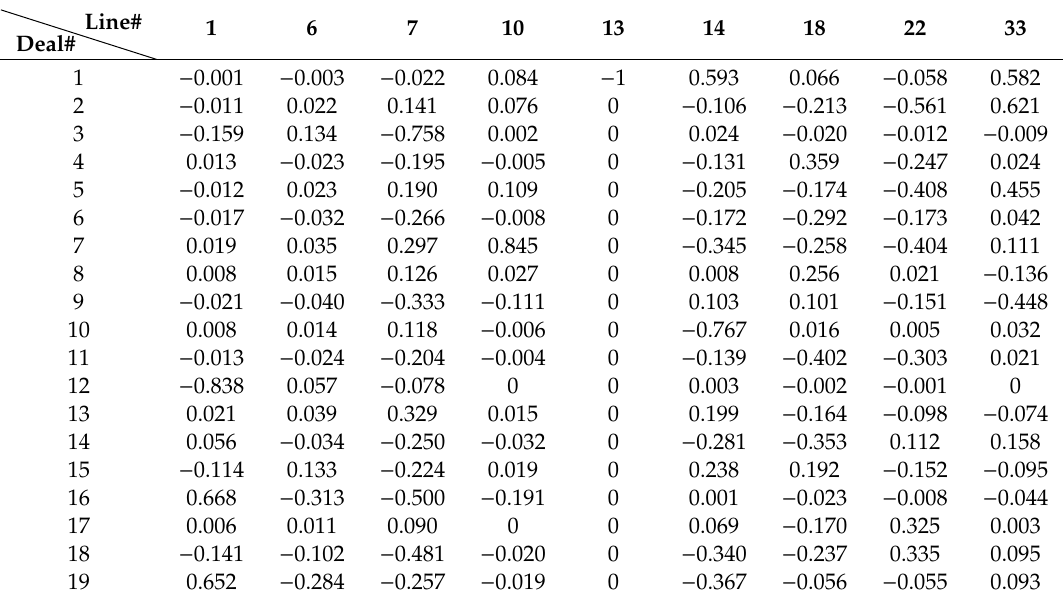
Table 3. PTDFs of nine lines in the 30-bus test system.